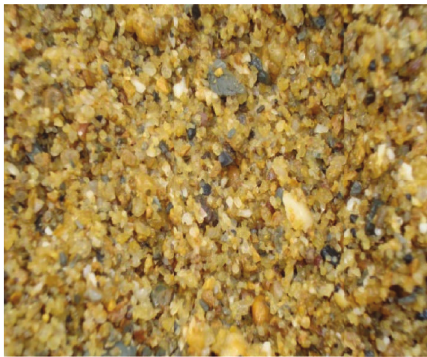
Figure 14: Core sample of fine gravel before grouting.